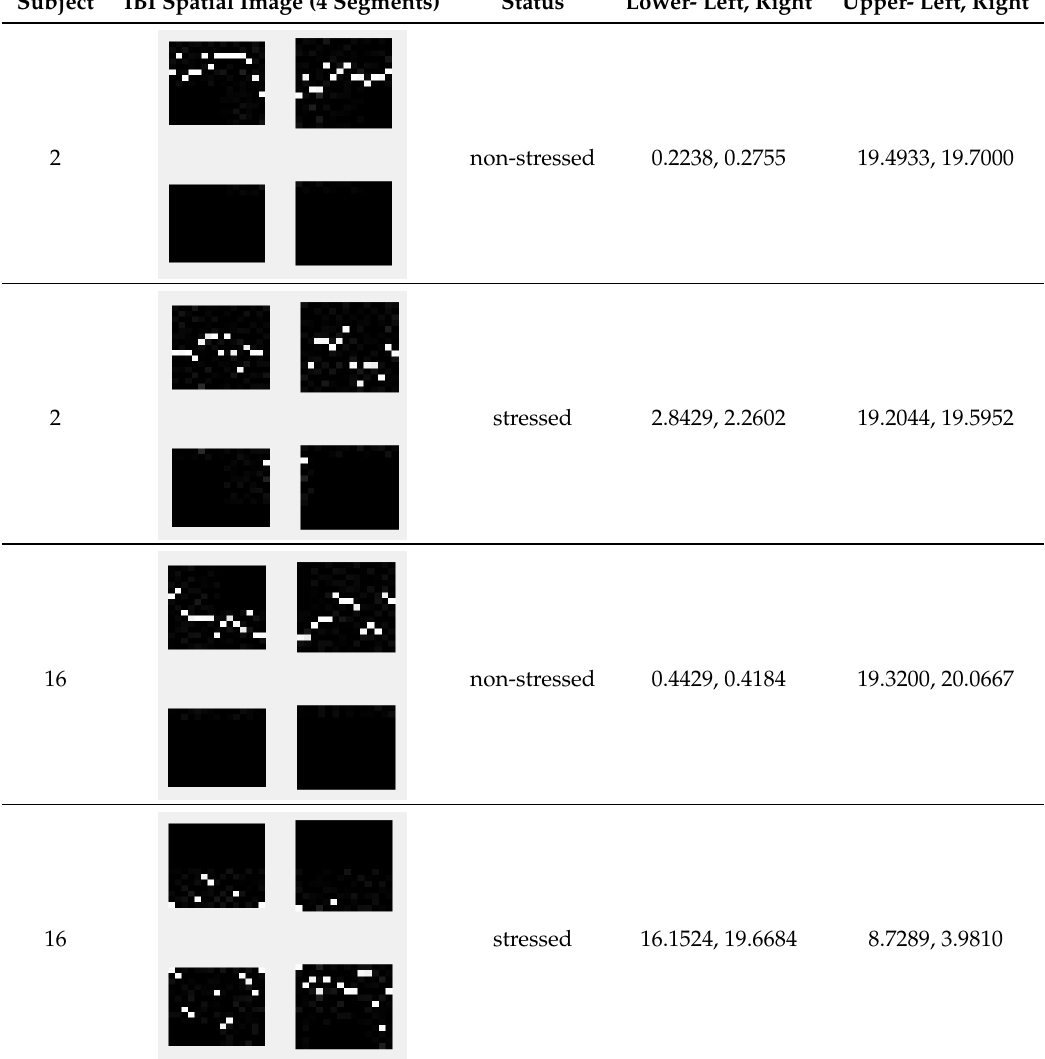
Table 2. Comparing the average intensity value of the image segments in stressed and non-stressed